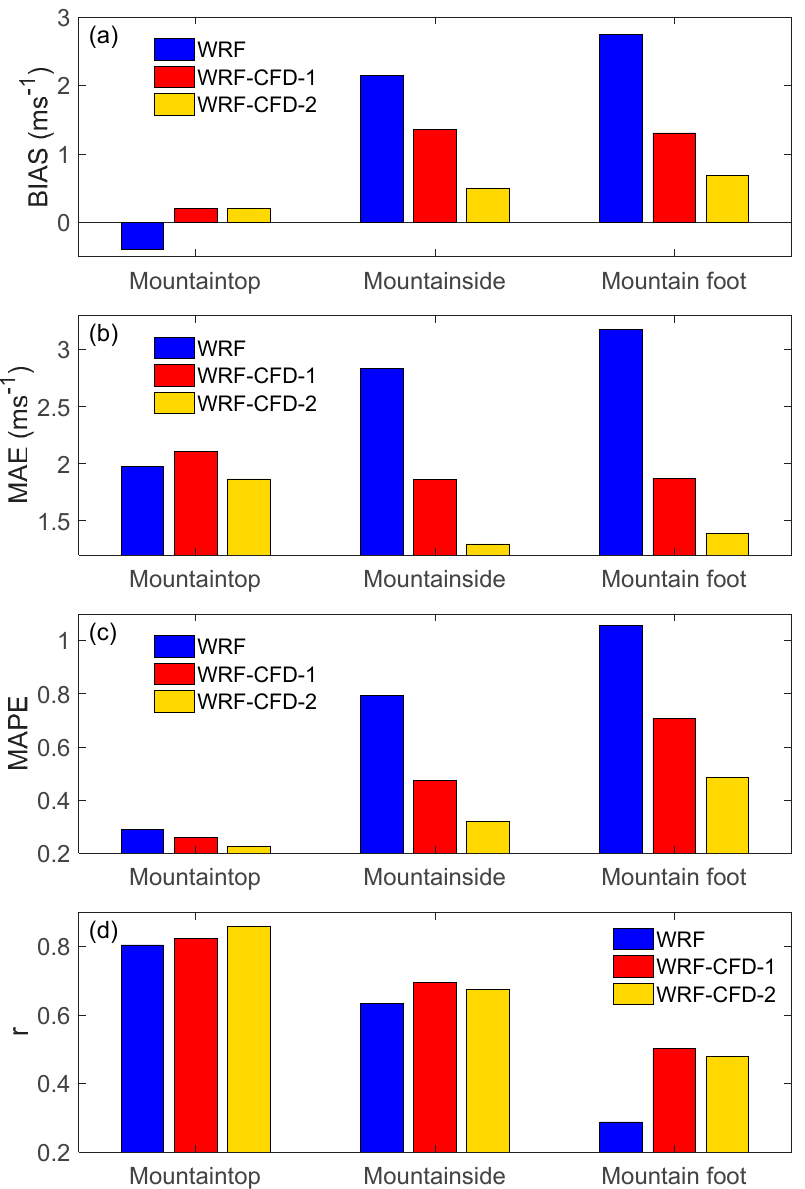
Figure 11. Index BIAS, MAE, MAPE, and r calculated using di ff erent models: WRF, WRF-CFD-1, and WRF-CFD-2: ( a ) BIAS; ( b ) MAE; ( c ) MAPE; ( d ) r